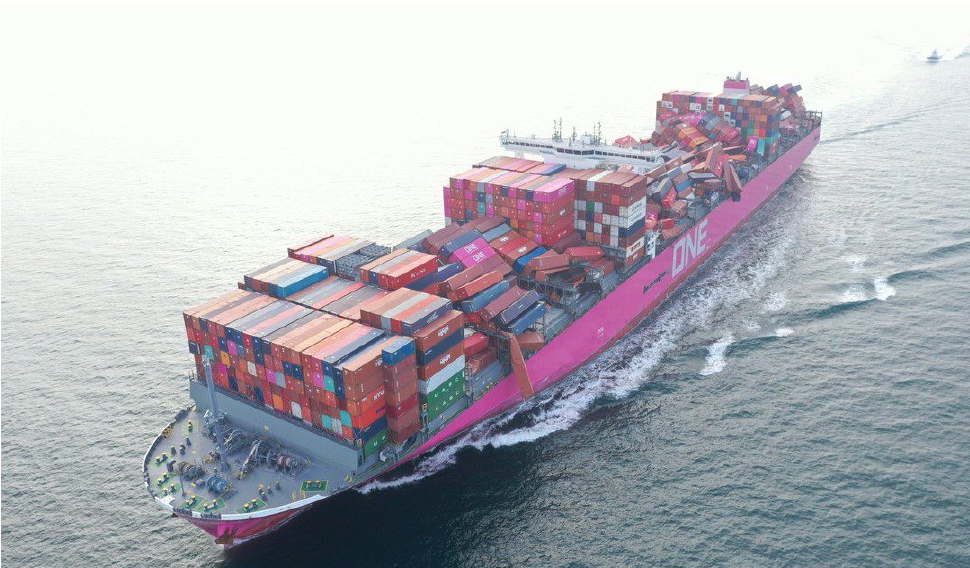
Figure 31. The ONE Apus arrives in Kobe, Japan, on 8 December 2020 after losing an estimated 1816 containers overboard, approximately 1600 nautical miles northwest of Hawaii, USA. Photo courtesy W K Webster and Co. Sidcup, UK